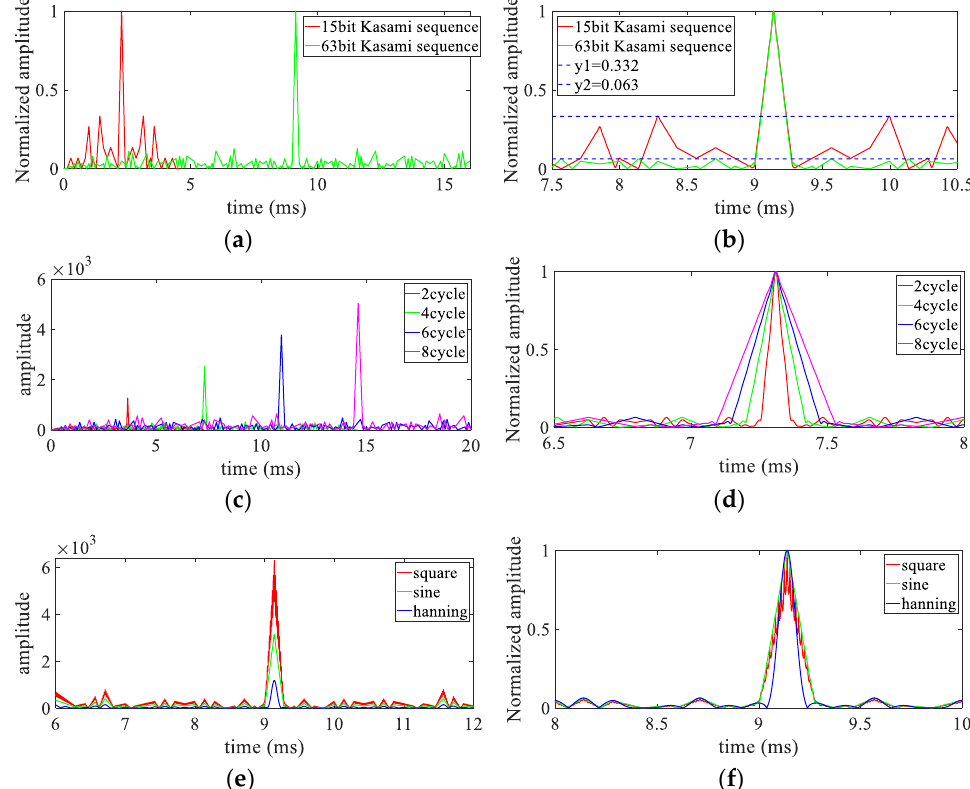
Figure 5. ACF envelopes analysis of Kasami sequences, ( a ) and ( b ) comparing the effect of different bits on ACF envelopes, ( c ) and ( d ) comparing the effect of different cycles on ACF envelopes, ( e ) and ( f ) comparing the effect of different carrier waveform.